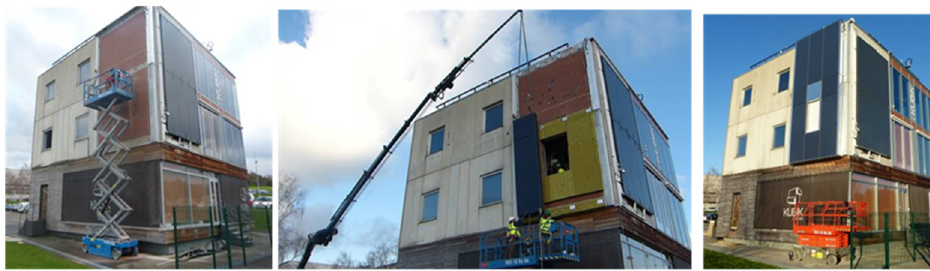
Figure 12. Installation of the plug and play façade system.